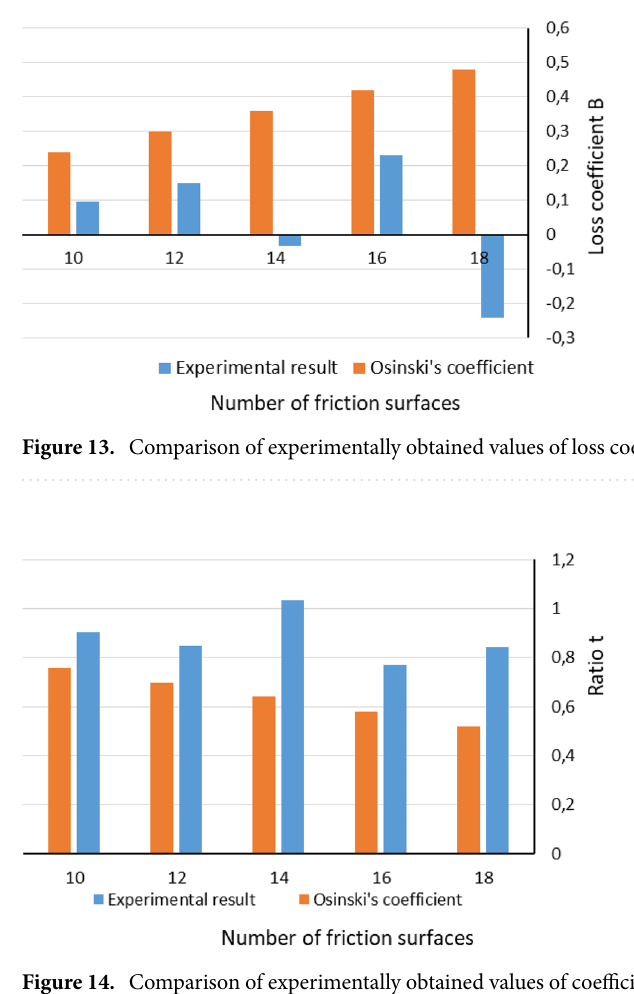
Figure 14. Comparison of experimentally obtained values of coefficient t with Osinski’s coefficients.